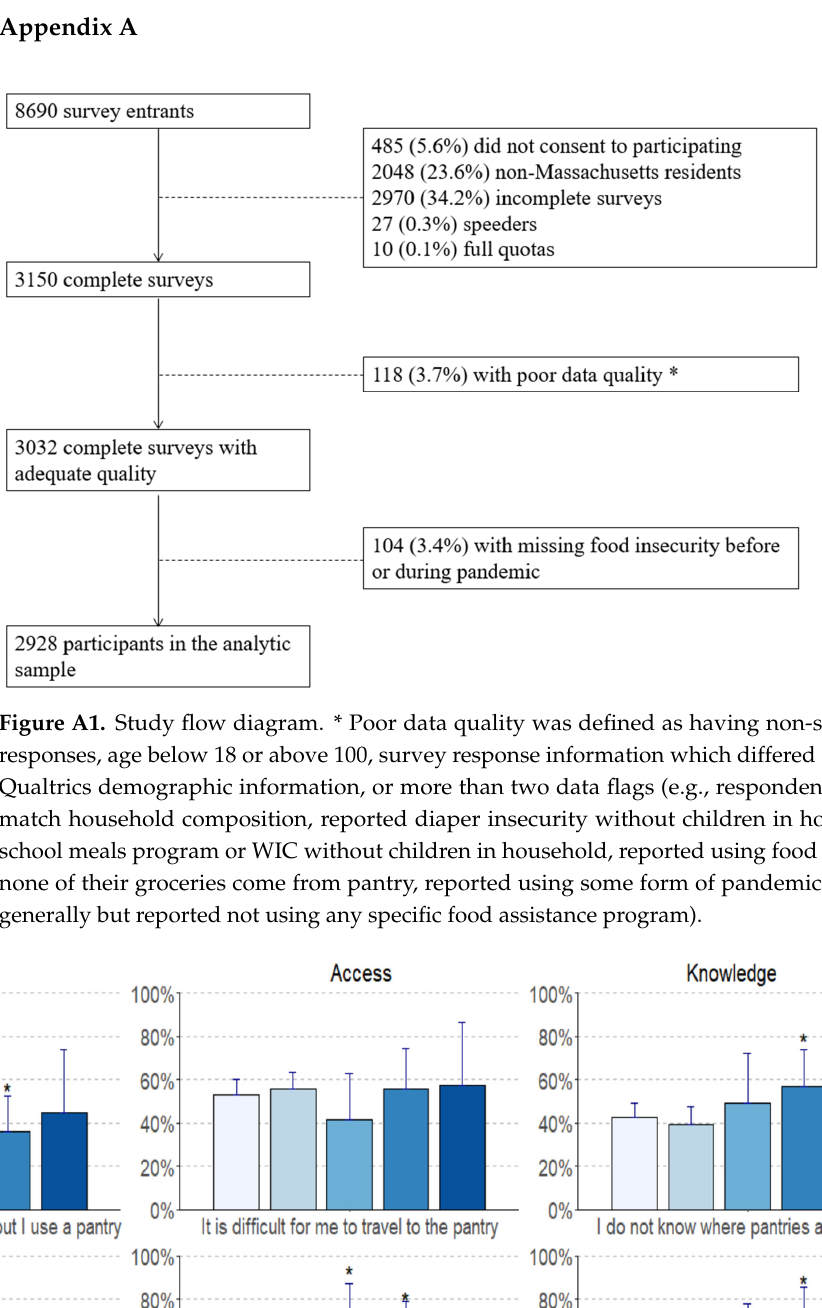
Figure A3. Experiences with food pantries among food-insecure adults during the COVID-19 pandemic. Chi-square tests were performed for each statement for each racial/ethnic group com- pared to the white reference group; * indicates a p -value < 0.05.